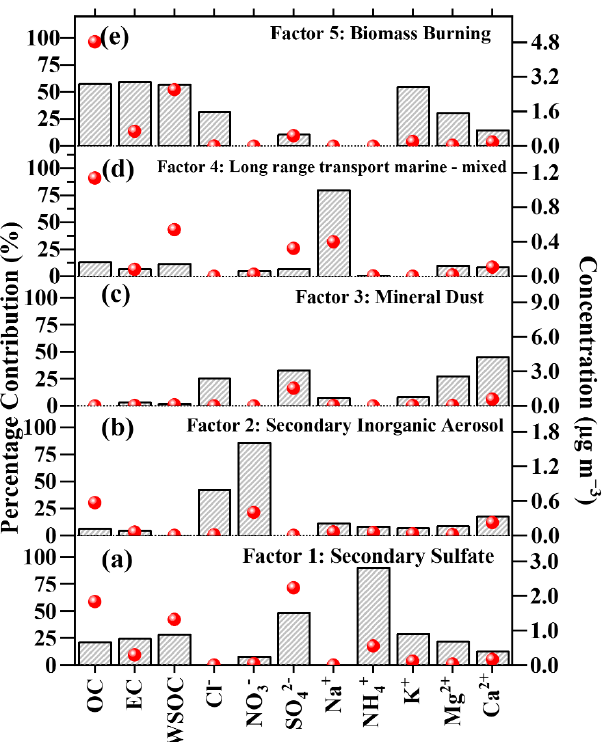
Figure 6. PMF-resolved factor profile for 5 sources. The boxes show the percentage contribution of a chemical species explained by a source, and the red dots show the concentration of chemical species from an individual source resolved by PMF. ( a ) Factor 1: Secondary Sulfate. ( b ) Factor 2: Secondary Inorganic Aerosol. ( c ) Factor 3: Mineral Dust. ( d ) Factor 4: Long rang trabsport marine. ( e ) Factor 5: Biomass Burning.